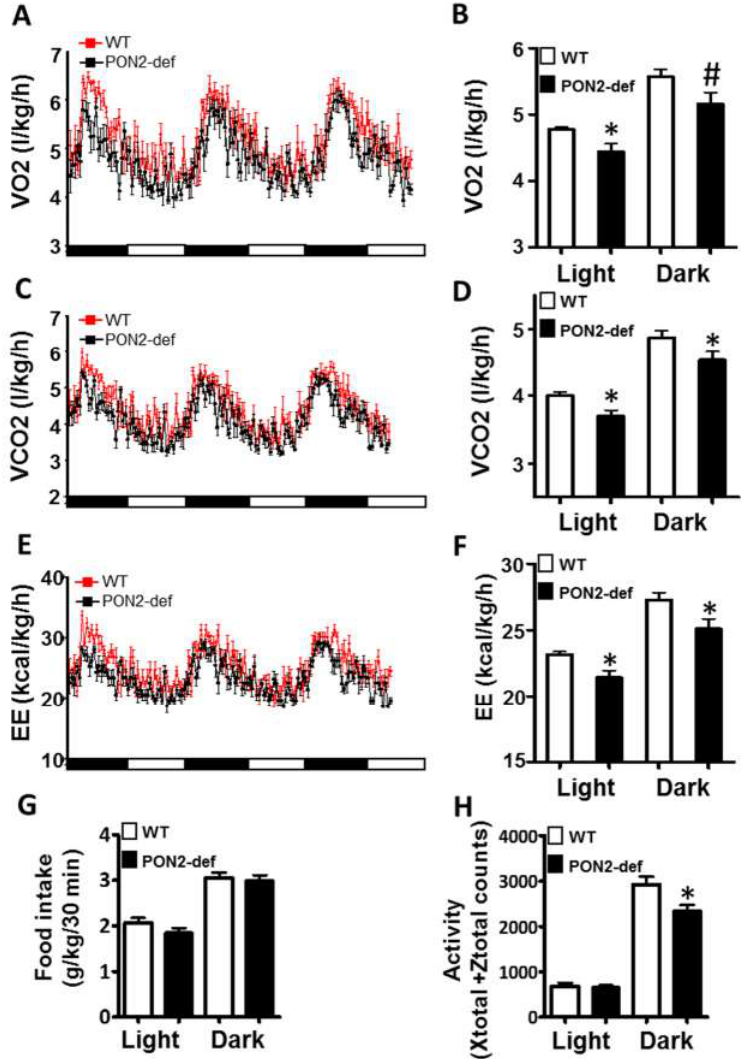
Figure 2. PON2-def mice exhibit altered metabolic phenotypes as compared to the WT mice. Two-month-old female PON2-def and wild-type (WT) mice were fed an obesifying diet for 2 weeks before they were placed individually in metabolic chambers for 3 days to measure metabolic parameters including ( A , B ) oxygen consumption rate, ( C , D ) CO2 production rate, ( E , F ) energy expenditure (EE), ( G ) food intake, and ( H ) activity. n = 6 for each group. 12-h light/dark cycles; 72-h total duration; and each light/dark bar represents 12 h duration. After 8 h of acclimation, data from the last 64 h of the 72 h experiment were used for data analysis. #: p < 0.07, *: p < 0.05, vs. WT group.